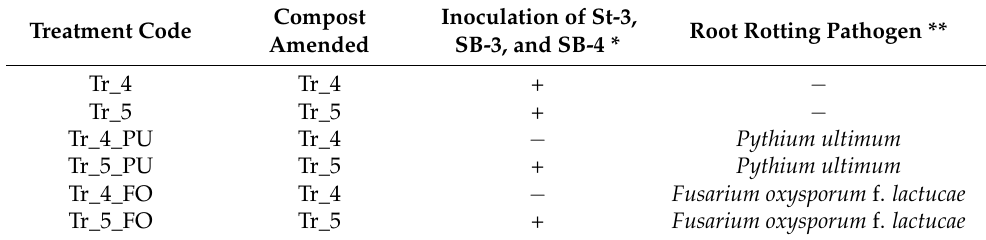
Table 4. Effects of the potential plant growth-promoting bacteria ( Bacillus cereus SB-3 and Bacillus toyonensis SB-4) and the pathogen-inhibiting bacterium ( Streptomyces sasae St-3) on pepper plants infected with the root rot plant pathogens Fusarium oxysporum f. sp. lactucae (KACC 42795) and Pythium ultimum (KACC 40705) in the pot